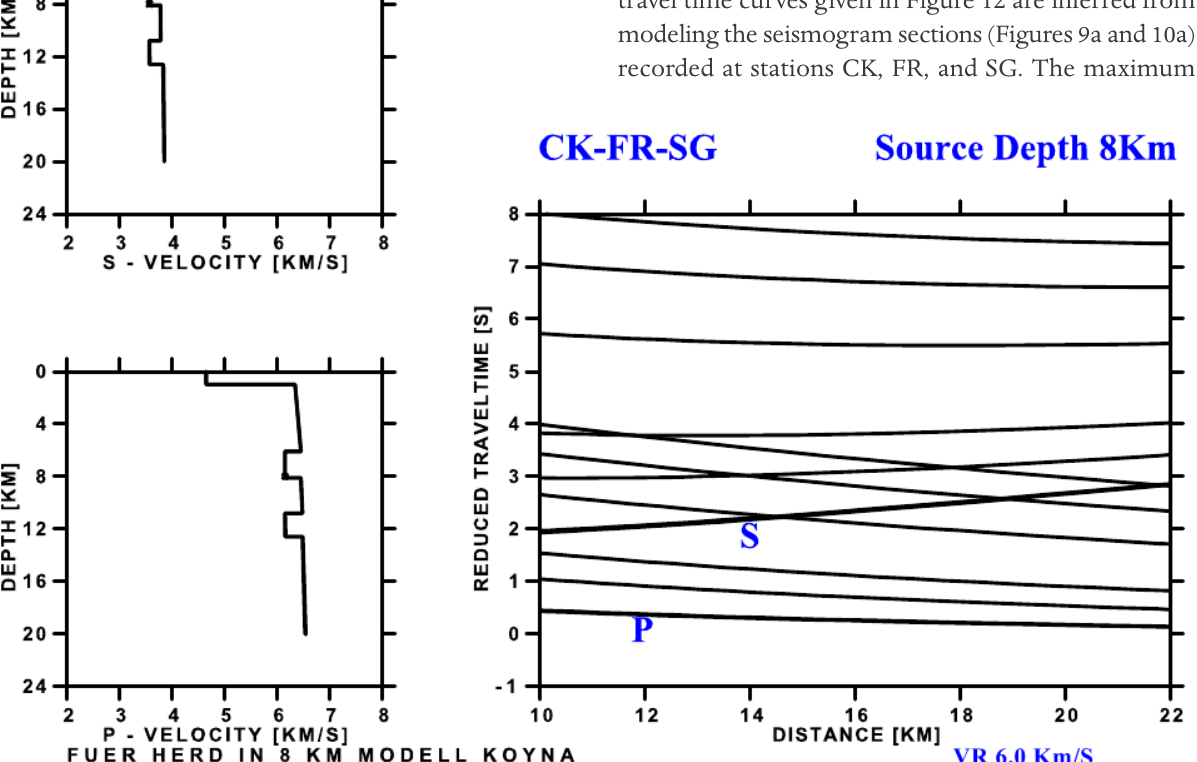
Figure 12. Inferred set of final P and S velocity models and the resulting travel time curves (for ray paths illustrated in Figure 11) reproduc- ing the prominent features in both the seismogram sections (Figures 9 and 10), but with different sets of the source parameters in order to generate the synthetics reasonably matching both the observed